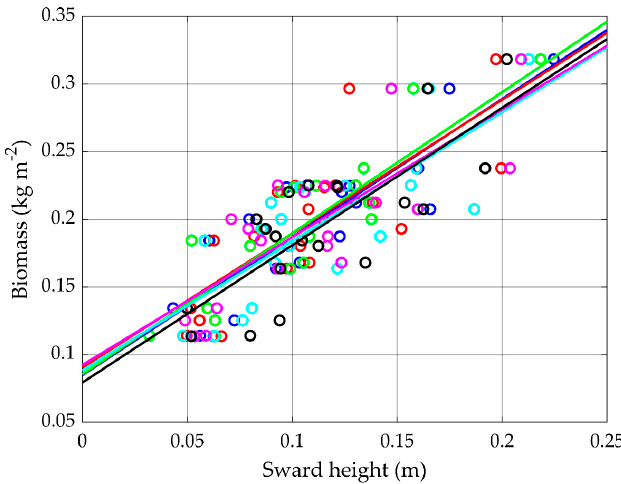
Figure 13. Linear regressions of biomass versus sward height for six passes at 10 km h − 1 from Transect 3.